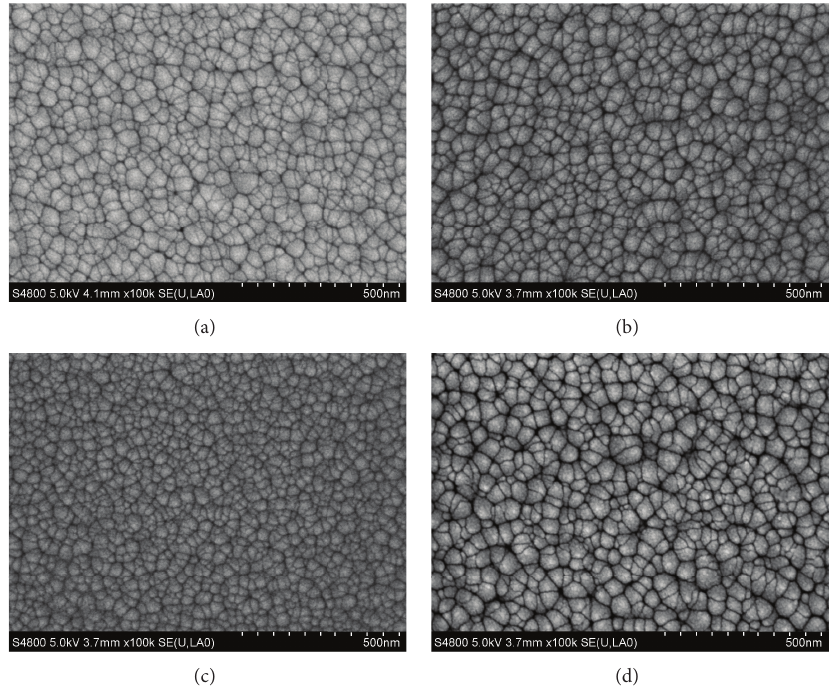
Figure 5: SEM images of ZnS films grown in various atmospheres. (a) 0.5P-Ar, (b) 0.5P-H, (c) 0.5P-2H, and (d) 0.5P-3H.